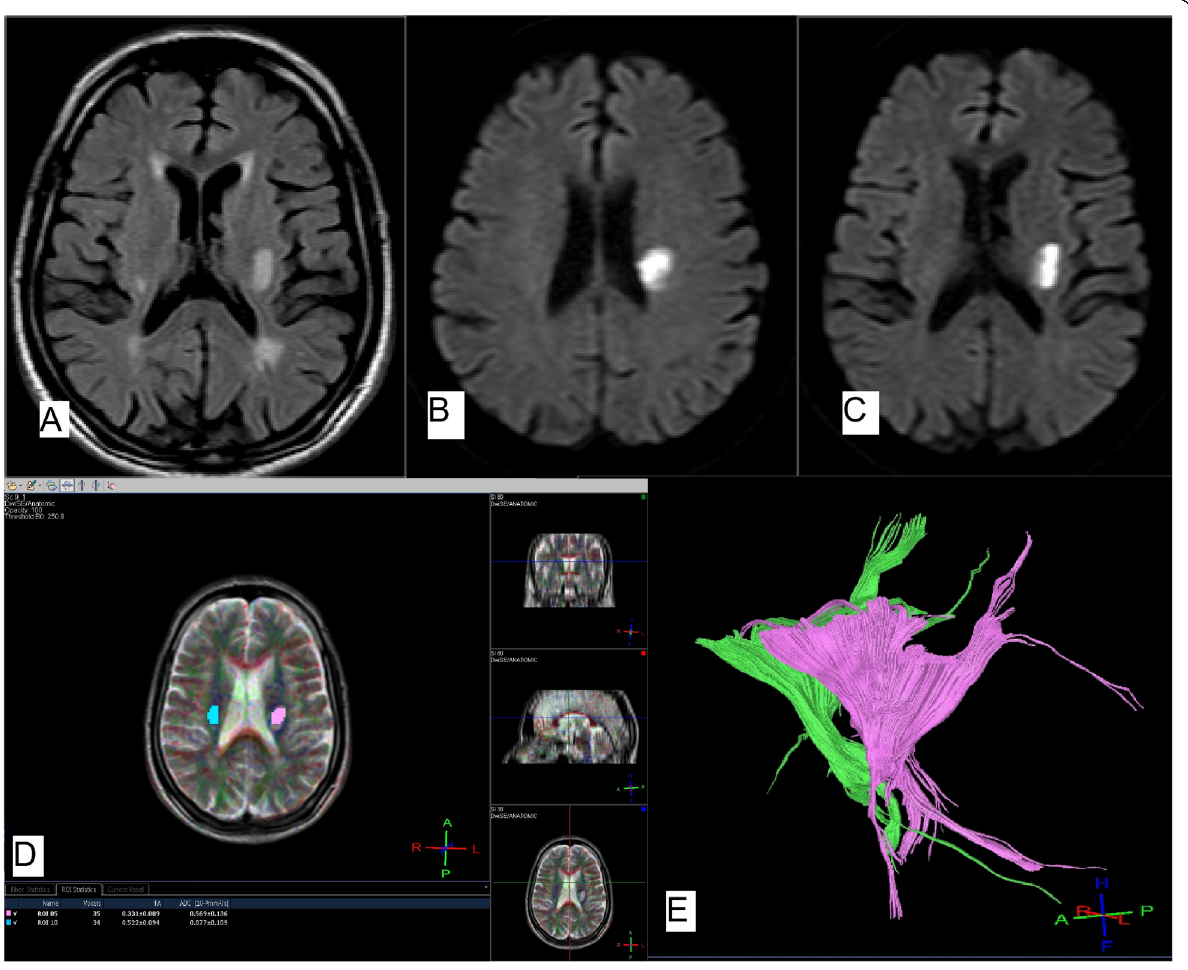
Fig. 2 A 75-year-old male patient, diabetic and hypertensive, presented with right hemiplegia. NIHSS on admission was 9. a Axial FLAIR and b , c axial diffusion WIs (b1000) show left corona radiata and posterior limb of internal capsule area of high FLAIR signal and restricted diffusion in keeping with acute infarct. d Axial color-coded FA map overlaid on axial T2 images showing reduced FA value at the site of infarct (0.3) compared to the contralateral normal side (0.5). e 3D fiber tractography of the CST showing disrupted some fibers of the left CST. The patient shows minimal clinical improvement with residual motor weakness. NIHSS after 3 months was